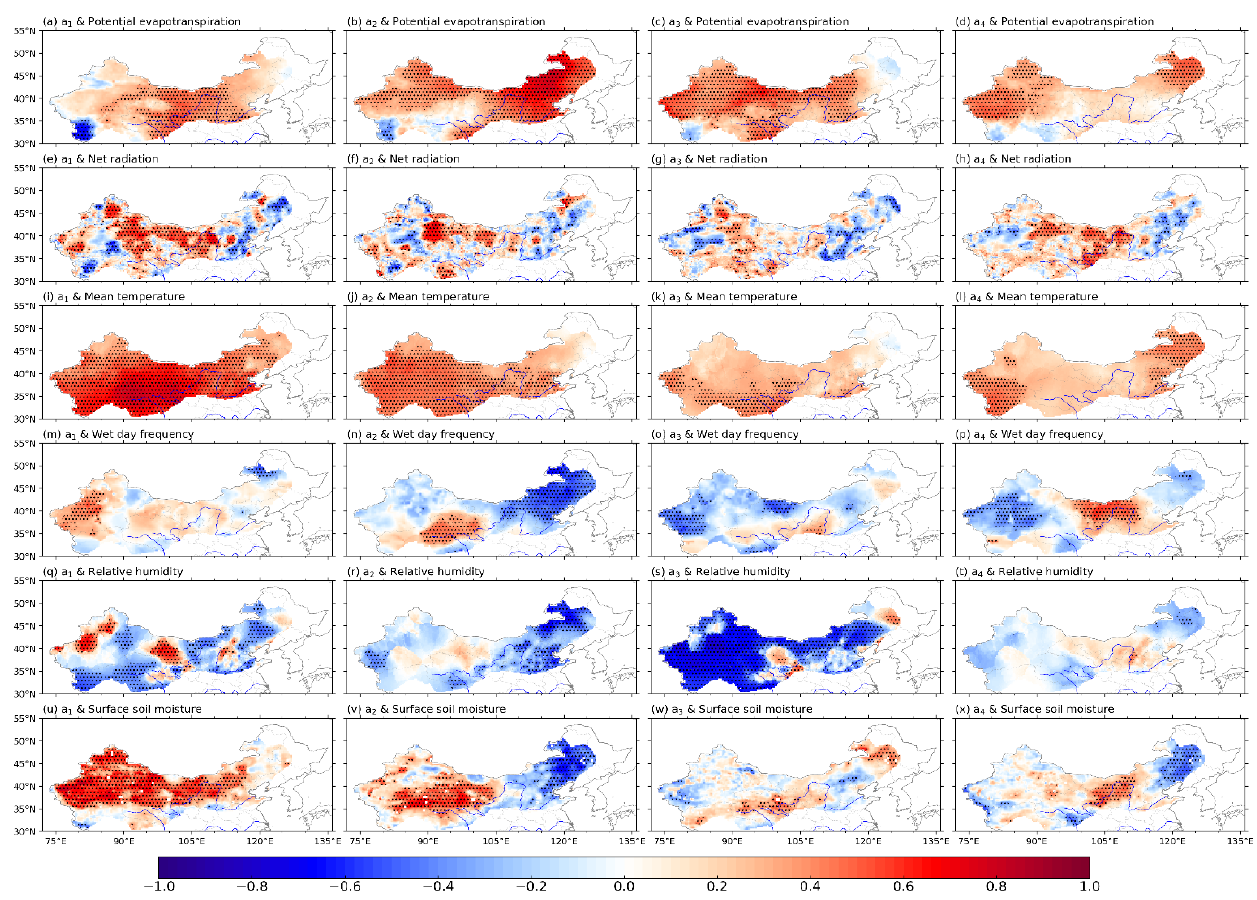
Figure 8 . Pearson correlation coefficients at each grid point between the corresponding temporal coefficients of ETa for the four leading modes of the SVD analysis and ( a – d ) potential evapotranspiration, ( e – h ) net radiation, ( i – l ) mean temperature, ( m – p ) wet-day frequency, ( q – t ) relative humidity, and ( u – x ) surface soil moisture in northern China during 1982–2017. The dots denote values exceeding the 95% confidence level.